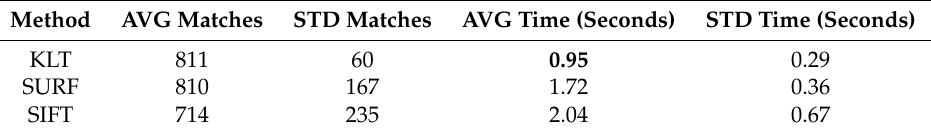
Table 2. Statistic details of correspondence matching using KLT, SURF and SIFT on 2005 and 2006 Middlebury stereo datasets.